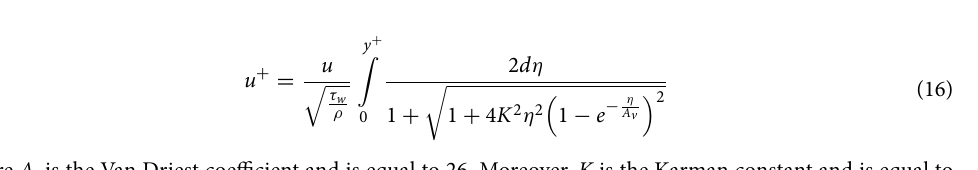
Figure 5. The images of unstructured tetrahedral grids in present study (Images used courtesy of ANSYS,